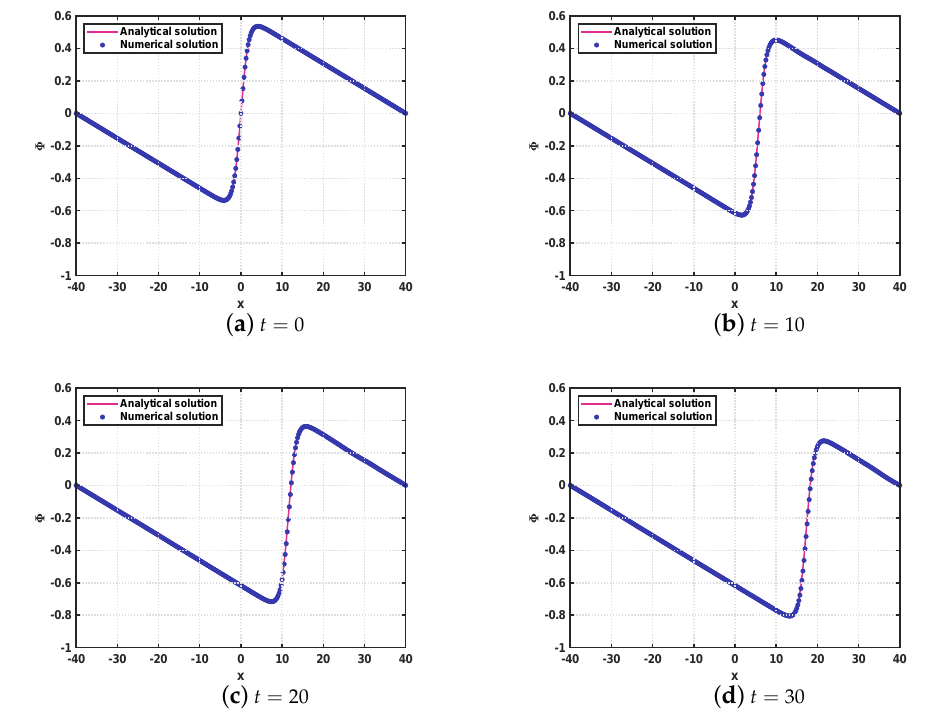
Figure 6. Comparison between numerical solution Φ f ( • ) and analytical solution Φ ( − ) with = 1 τ = τ C and h = 1 at different points in time for Case 2 of Example 4 100 4